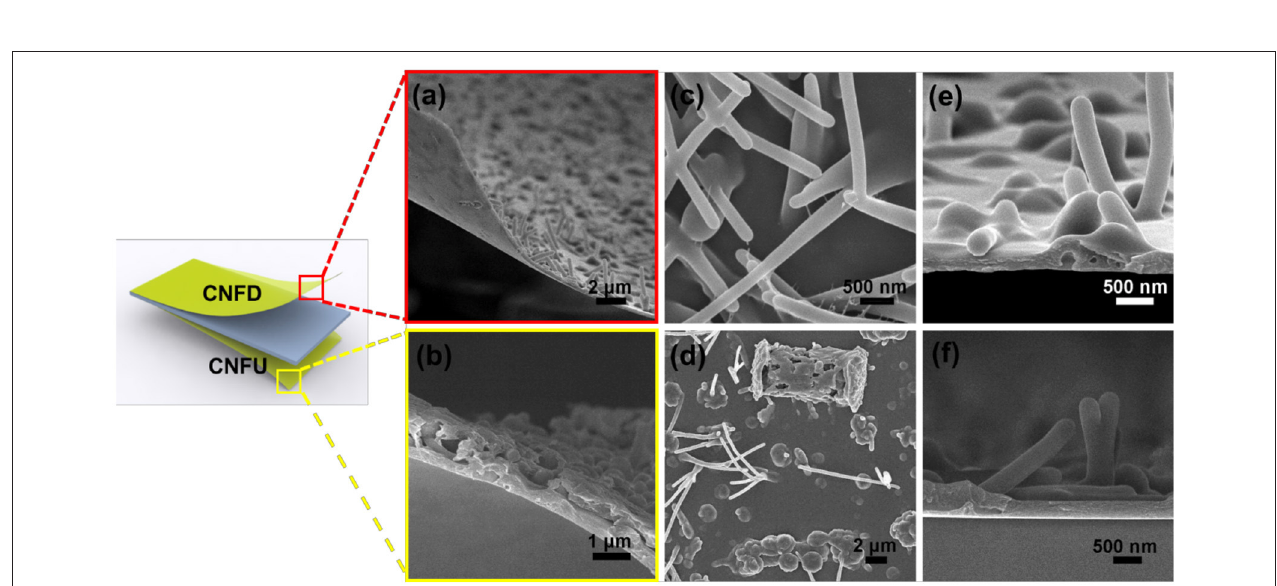
FIGURE 1 | SEM images of g-C 3 N 4 films. Overall views of CNFD (a) and CNFU (b) , top views of CNFD (c) and CNFU (d) , and cross section view of CNFD (e) and CNFU (f) , respectively.